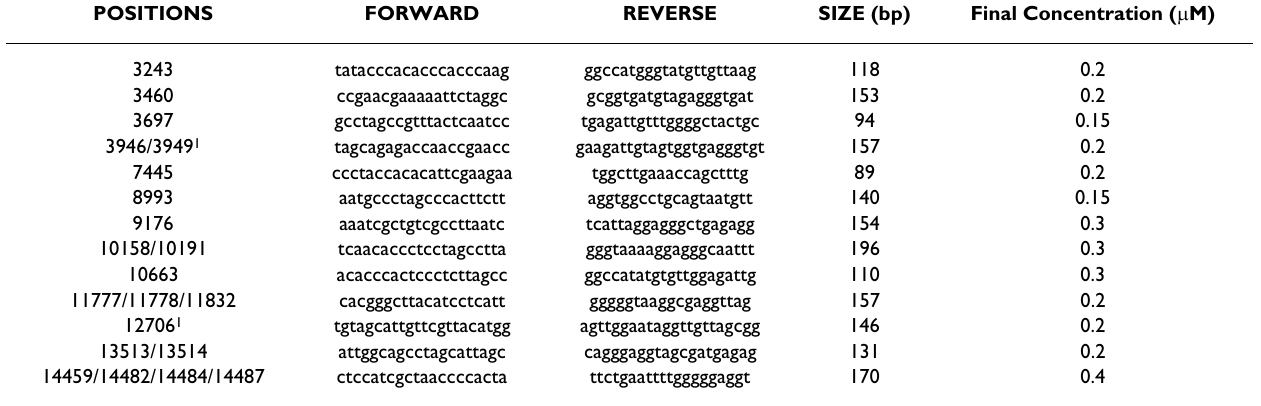
Table 2: Amplification primers